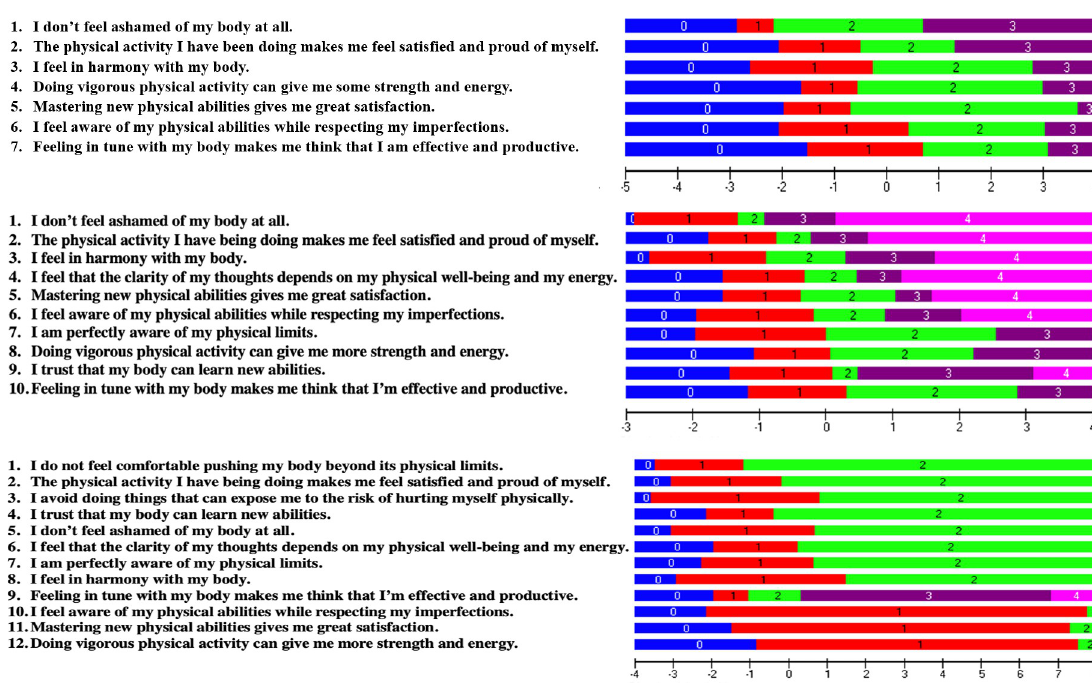
Fig 1. A. Item threshold map for community-dwelling older adults except stroke. B. Item threshold map for community-dwelling adults except stroke. C. Item threshold map for community-dwelling adults with chronic